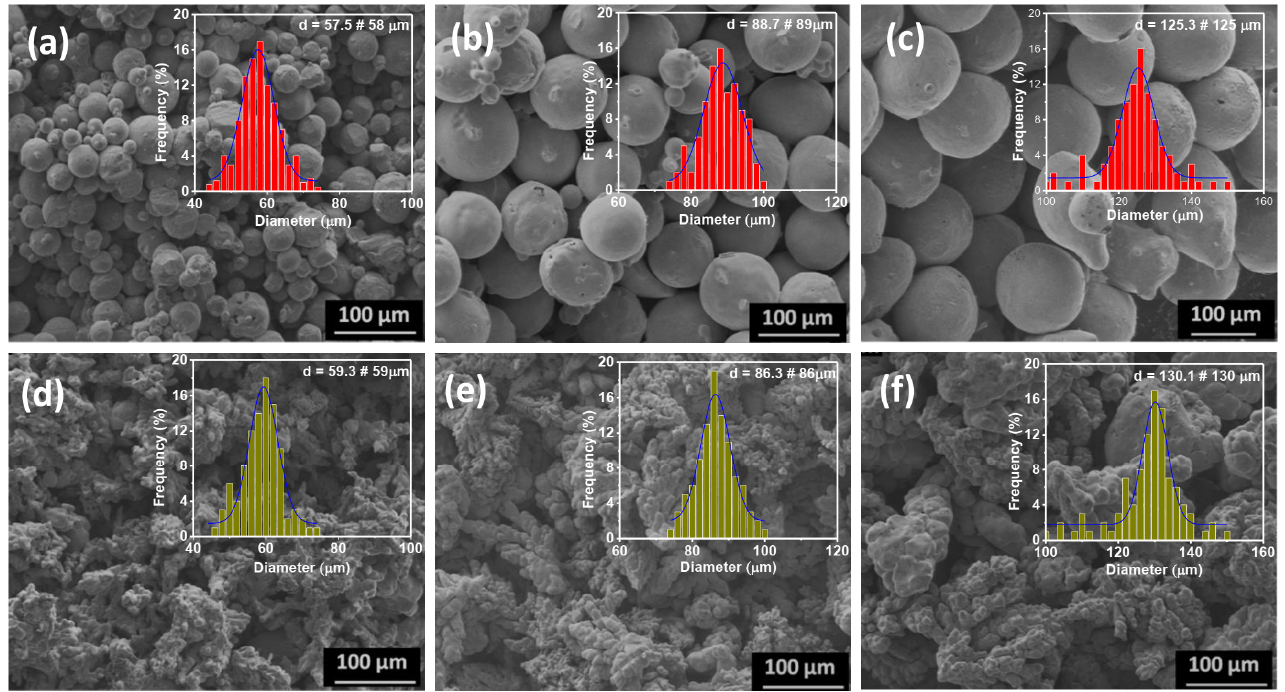
Figure 5. SEM images and particle size distribution of spherical Cu powders ( a ) 58 μ m, ( b ) 89 μ m, ( c ) 125 μ m and dendritic Cu powders ( d ) 59 μ m, ( e ) 86 μ m, ( f ) 130 μ m.